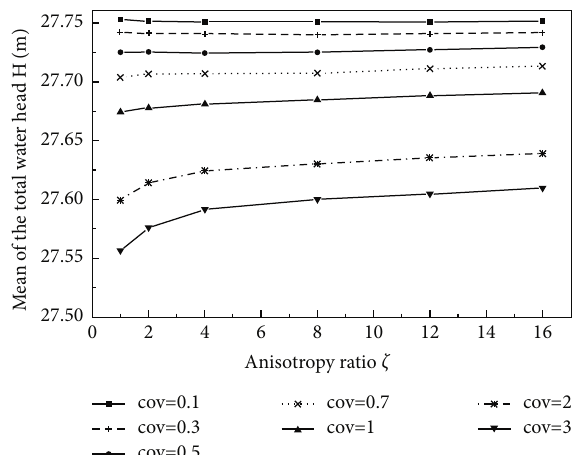
Figure 7: Mean of the total head versus anisotropy ratio of hydraulic conductivity.